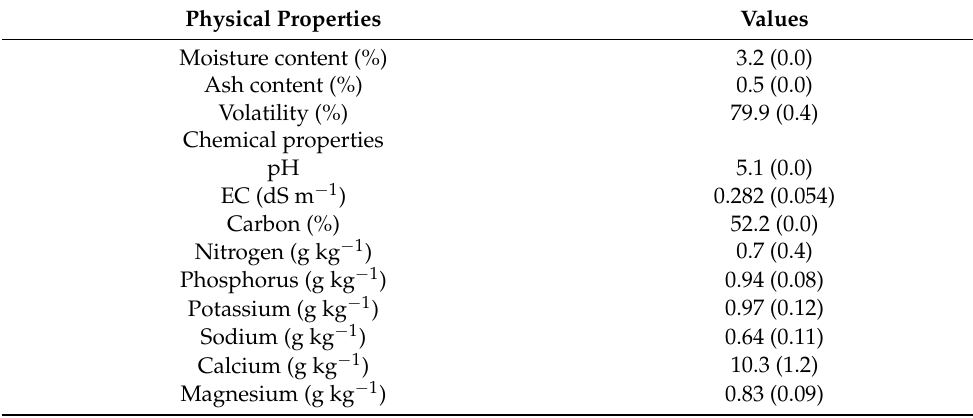
Table 1. Physical and chemical properties of the torrefied wood chips (TWC) of Quercus acutissima (adapted with permission from Cho et al. 2017 [41]). The values written in parentheses represent standard errors of the mean (n =